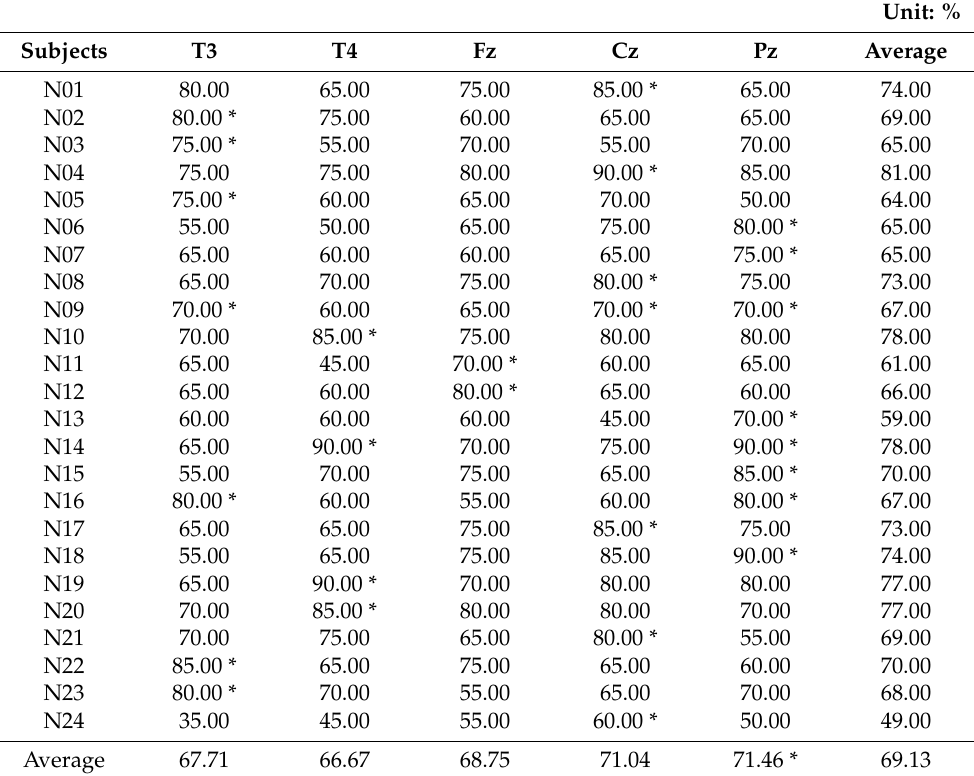
Table 4. The average accuracies by component N2P3 of the experimental trial using mental Shadow- ing